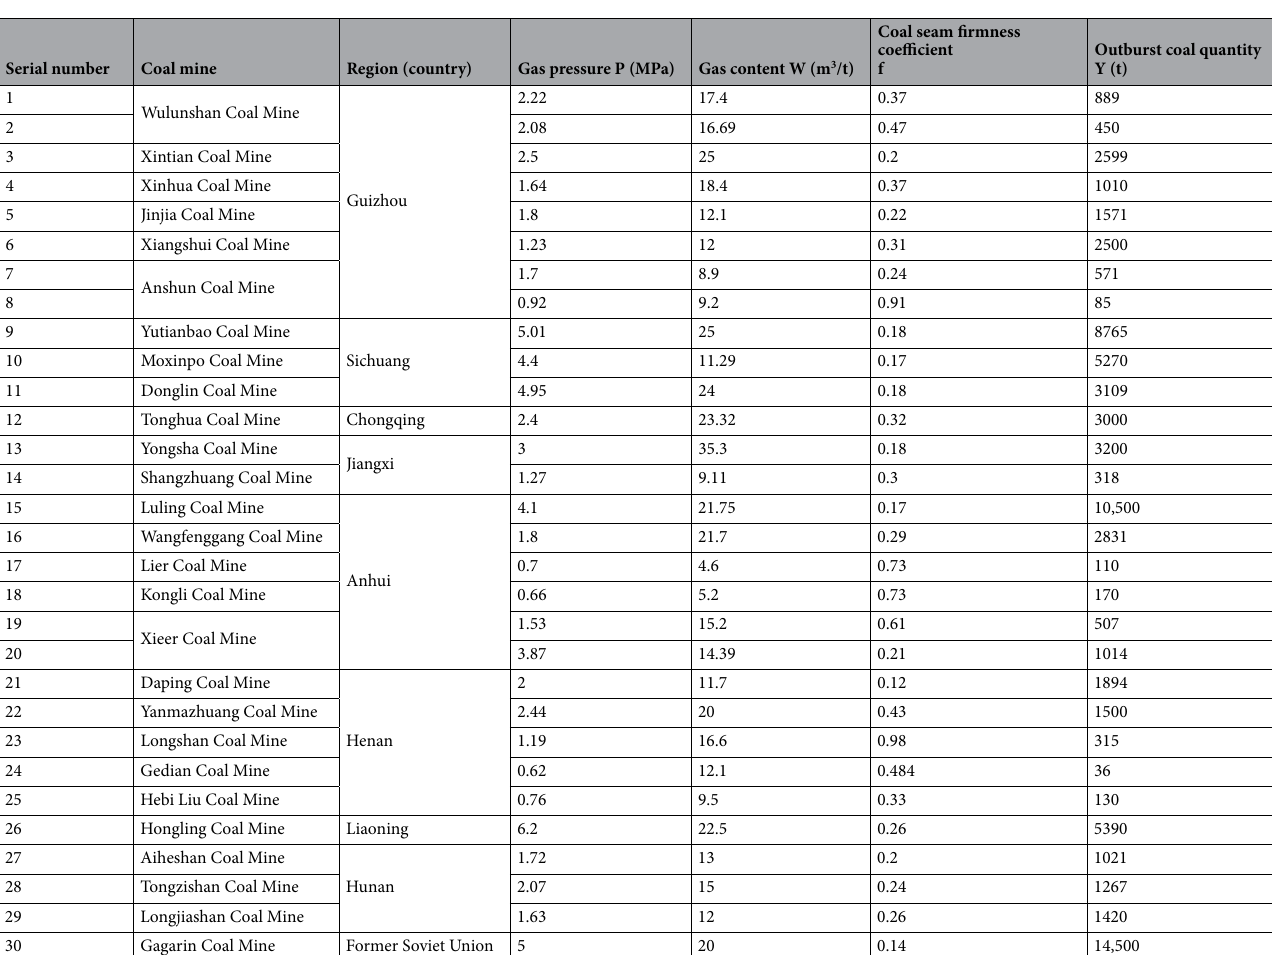
Table 1. Statistics of the outburst coal quantity and gas geological